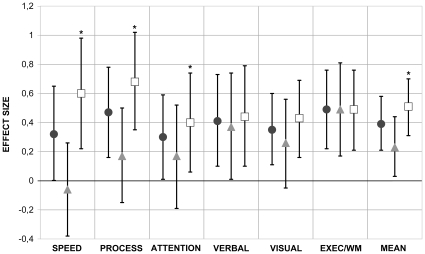
Cognitive Performance in the Total Group and Subgroups of Bipolar Patients.Total group (n = 110; dots), the euthymic subgroup (n = 46; triangle) and depressed subgroup (n = 64; square), with healthy controls (n = 75) used as reference score. Values are effect sizes, corrected for age. Error bars are 95% confidence intervals (95%CI). Statistical significance for group differences between bipolar patients and healthy controls was defined as p<0.05, shown in the figure as 95%CI which does not cross the base-line. Statistical significance (p<0.05) of sub-group differences were marked with an asterix (*) and were based on continuous depression scores. Speed  =  psychomotor speed; Process  =  speed of information processing; Attention  =  attentional switching; Verbal  =  verbal memory; Visual  =  visual memory; Exec/WM  =  executive functioning/working memory; Mean  =  mean z-score of all 6 cognitive domains.